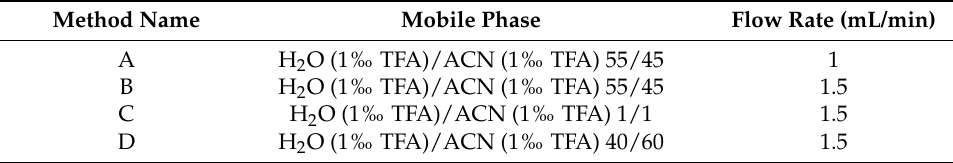
Table 3. HPLC Methods for the analysis of compounds 1 – 14